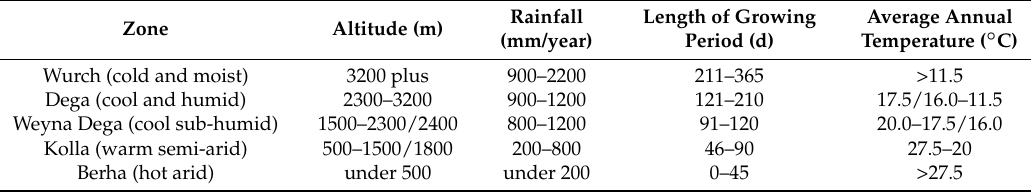
Table 1. Traditional Agro-climatic Zones and their physical characteristics.